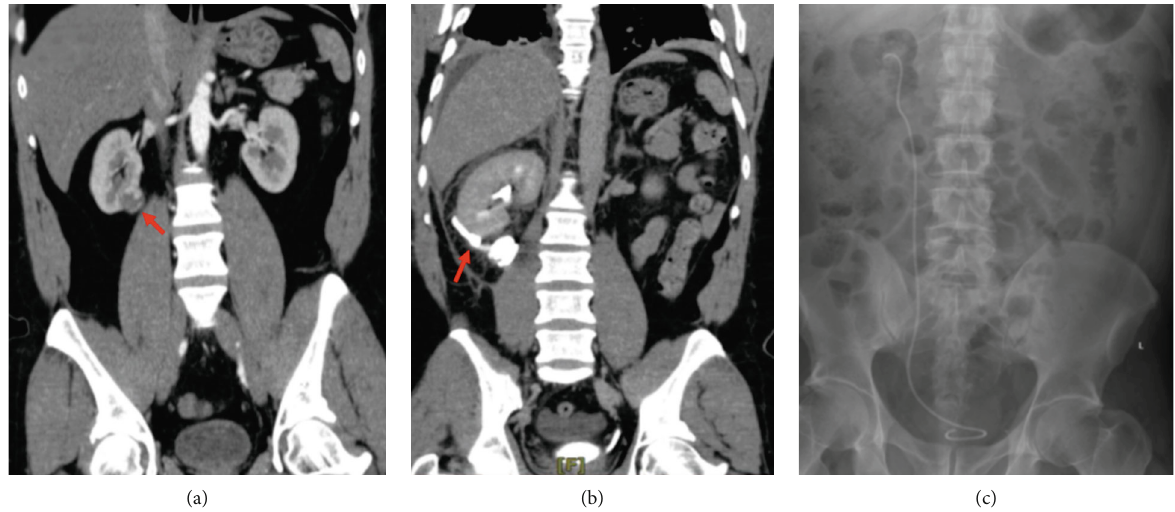
Figure 1: (a) Preoperative CT scan showing the lesion at the inferiomedial aspect of the right kidney. (b) Delayed phase CT scan demonstrating the urine leak from the site of partial nephrectomy. (c) Postoperative plain X-ray showing the JJ stent in